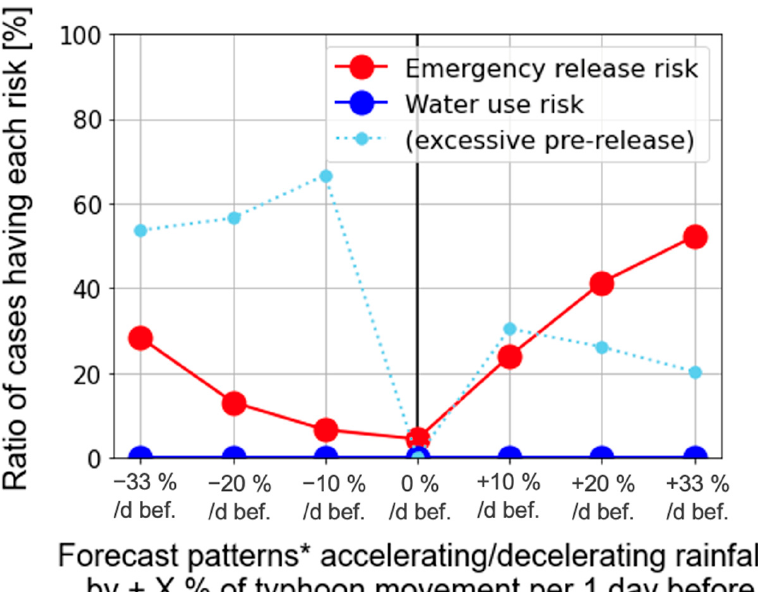
Figure 22. Ratio (%) of cases with emergency release risk in all pre-release typhoon cases (red) and water use risk and excessive pre-release in all pre-release and quasi-pre-release typhoon cases (blue, light blue) (excluding exceptions) when using rainfall forecast with the acceleration/deceleration of rainfall zone.